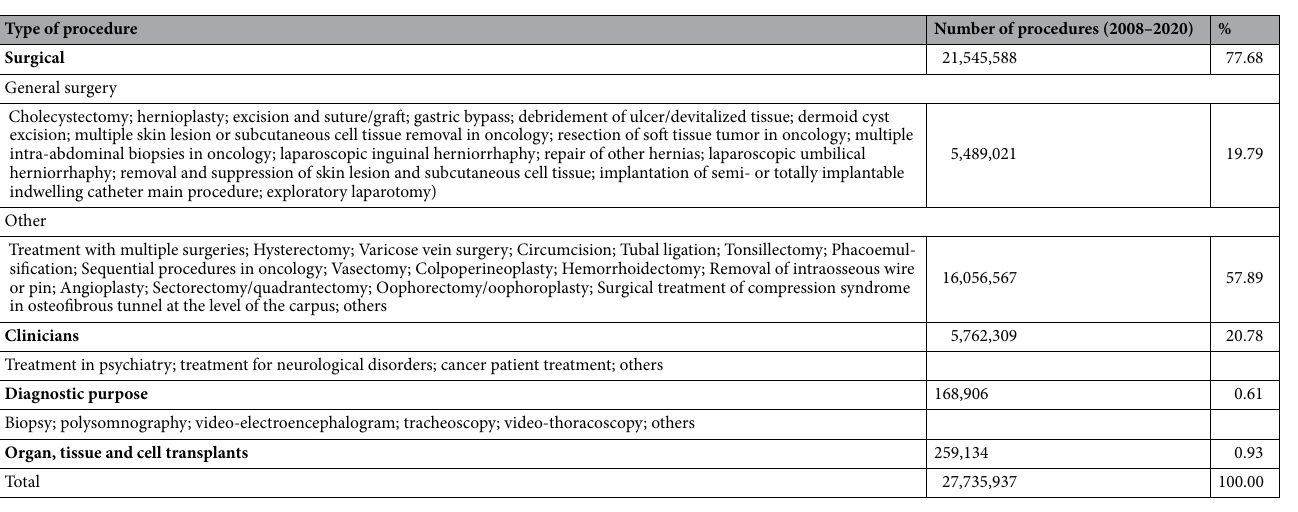
Table 1. Frequency of the elective procedures by type of procedure, Brazil,